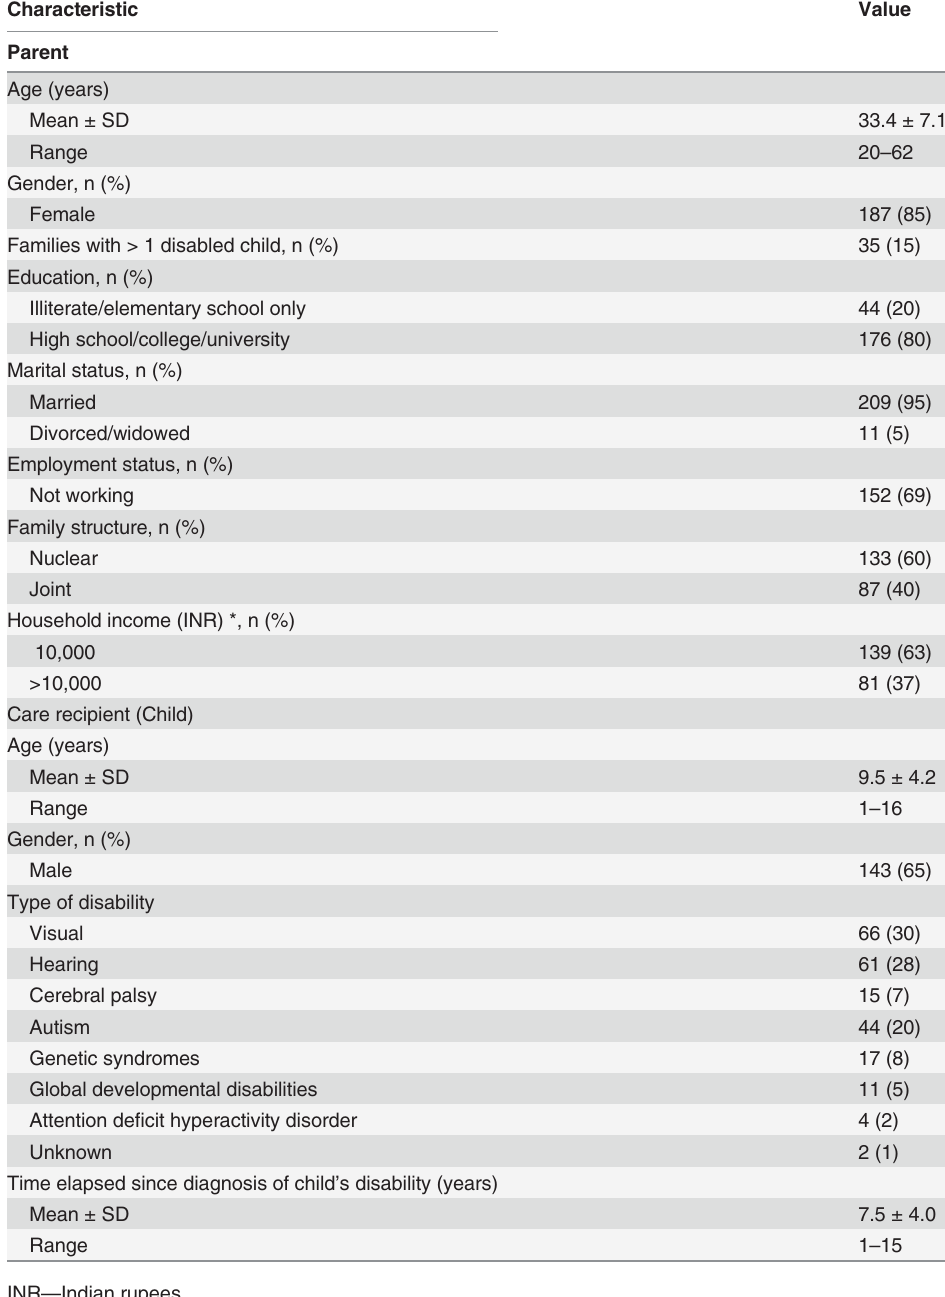
Table 2. Sociodemographic characteristics of parents of children with disabilities who responded to the Coping Health Inventory for Parents (n =